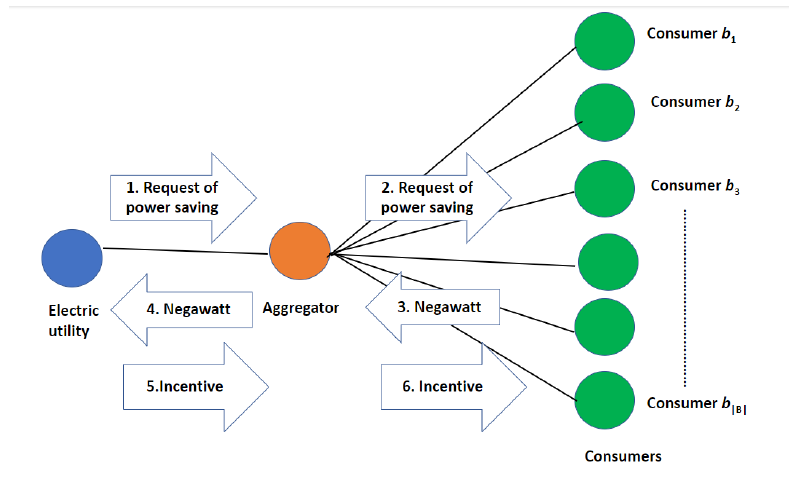
Figure 1. Nagawatt trading